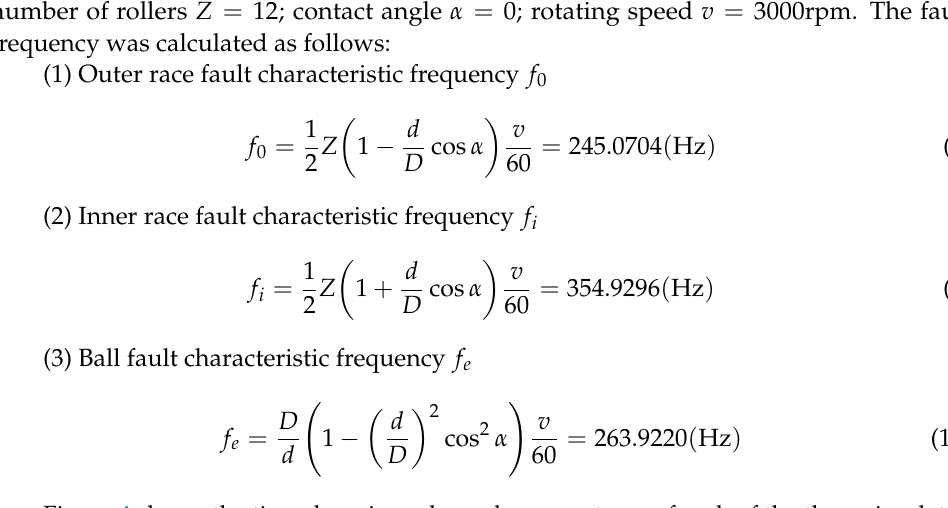
Table 1. Bearing parameters.